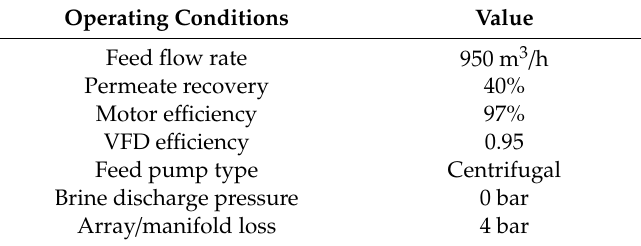
Table 6. Hydraulic assumptions for model calculations [41].